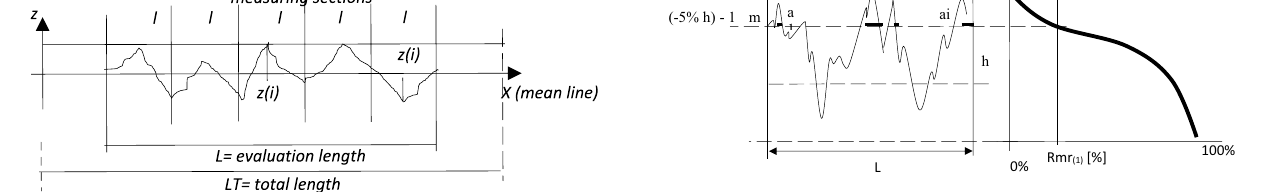
00.10.20.30.40.50.6